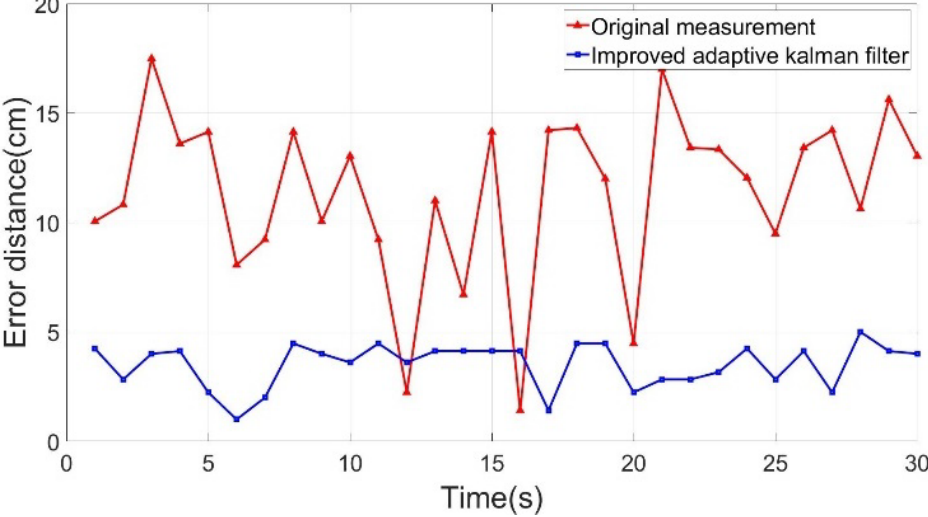
Figure 8. Distribution of the improved positioning points after being converged using the IAKF